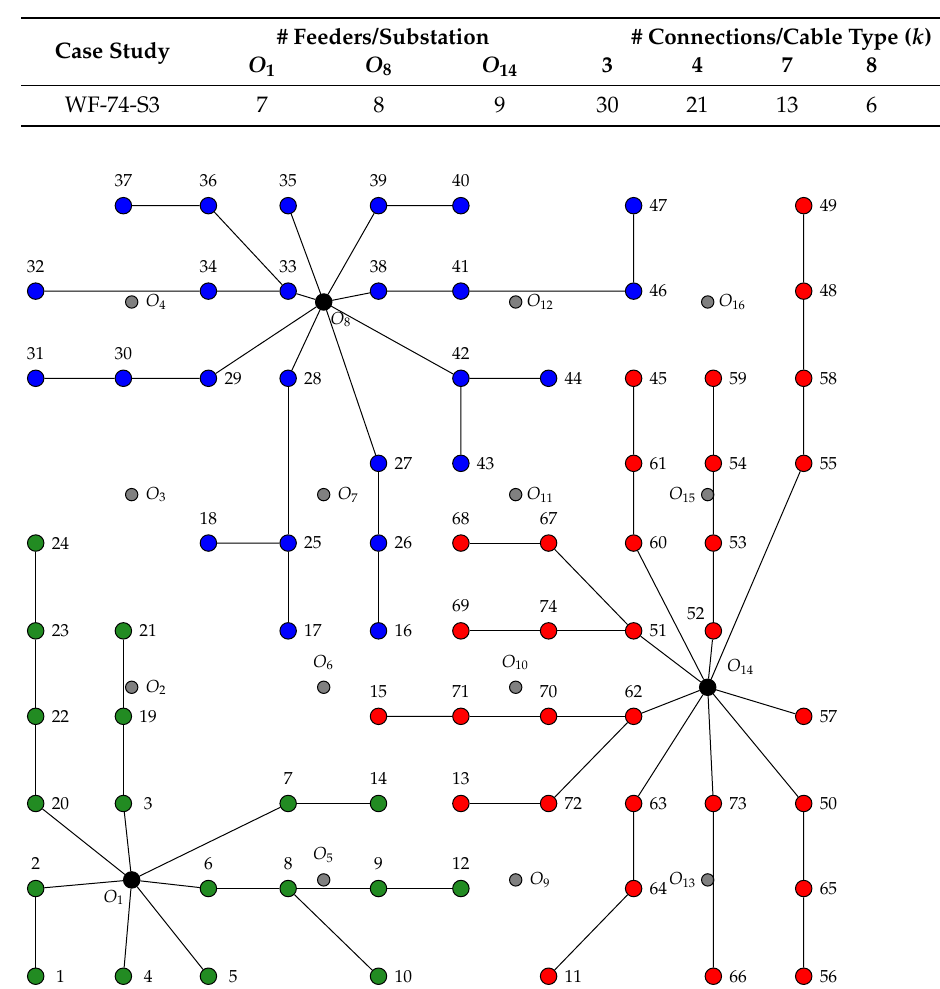
Table 5. Optimal solution cable type: WF-74-S3 wind farm.